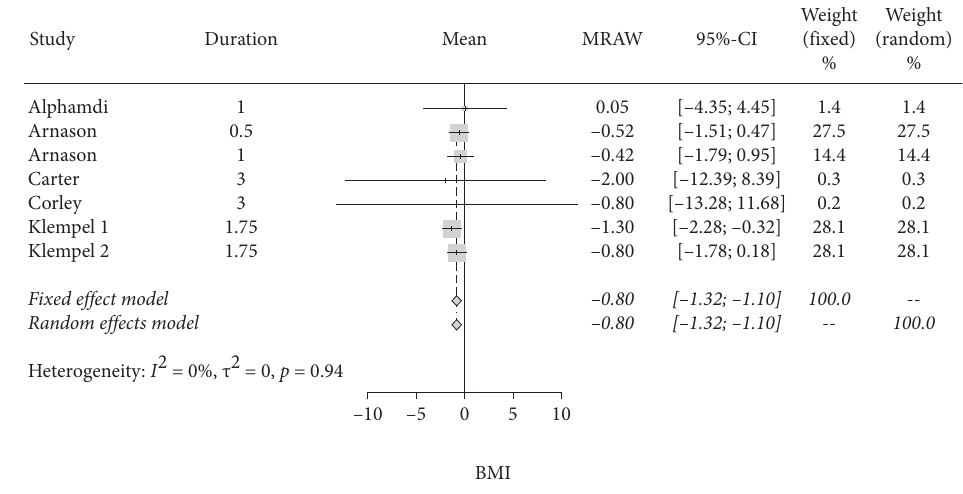
Figure 3: Forest plots for body weight, waist circumference, and BMI.